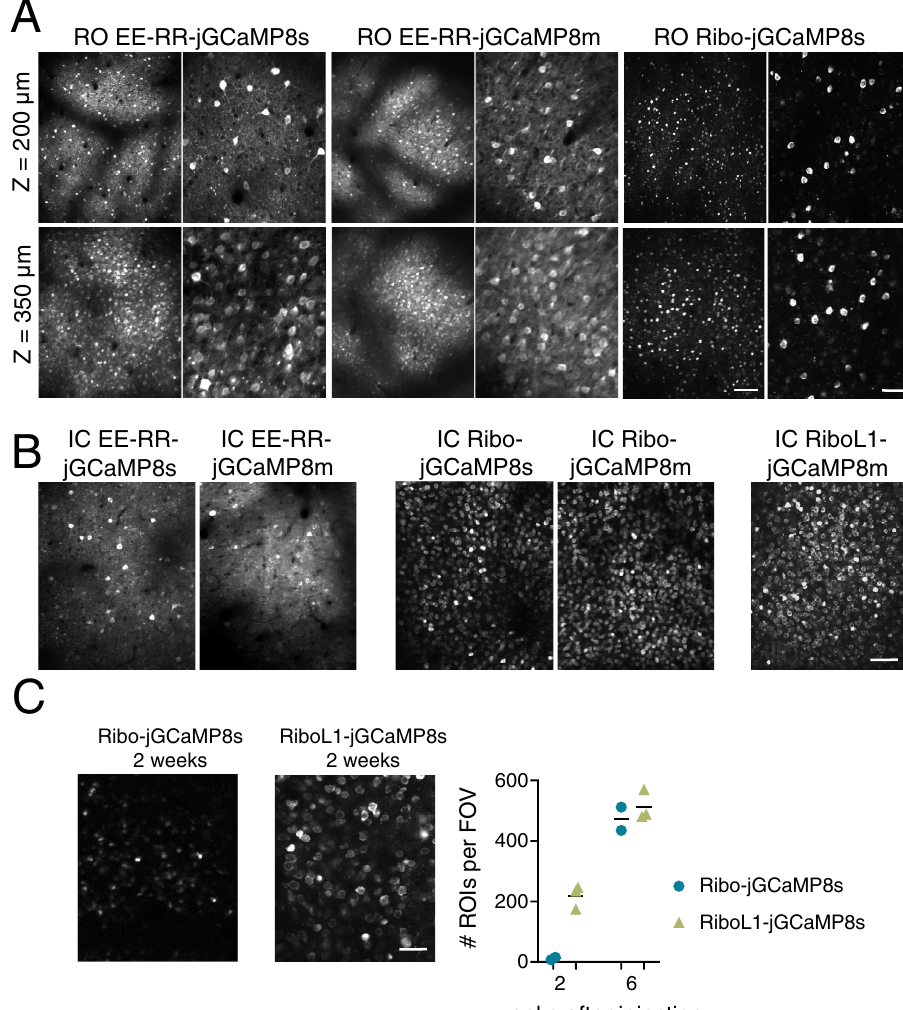
Fig. 3 | Soma-targeted jGCaMP8 expressed by RO and IC injections in primary visualcortex.A RepresentativeexampleimagesfromROinjectedmiceexpressing EE-RR-jGCaMP8sandm,andRibo-jCaMP8s,attwodifferentdepthsincortex.Scale bars on lowerright aligned images indicate 150 and 50 µ m, respectively. Allimages shown are average intensity projections from 2000 frames with identical adjust- ments to brightness and contrast. Data from EE-RR constructs was acquired 4 weeks after virus injections, and 6 weeks for the ribosome-tethered construct. B Similar to A , showing expression after IC injections. Note the high number of identi fi able single neurons with ribosome-tethering, compared to jGCaMP and EE-